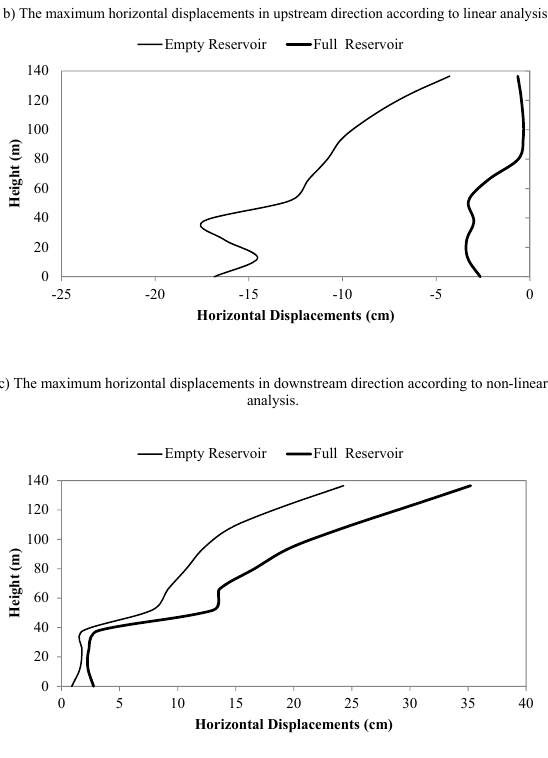
Fig. 15. The maximum horizontal displacements in VII-VII section.